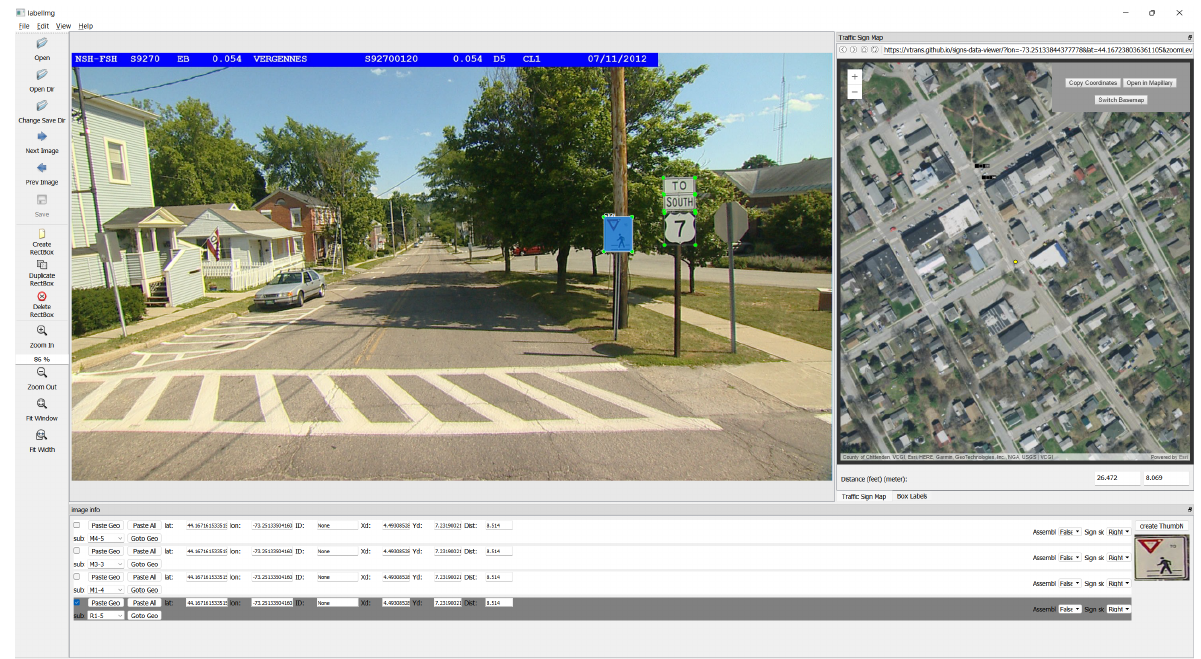
Figure 3. A sample image of the graphical user interface provided by our modified version on labelImg. The image being annotated is displayed in the upper left, and bounding boxes that have been annotated are overlaid on the image. The user can use the map displayed in the upper right to select the GPS coordinates for each sign. In the bottom pane, the user can enter all appropriate information associated with the sign, including its class, GPS coordinates, assembly attribute, sign side, and integer